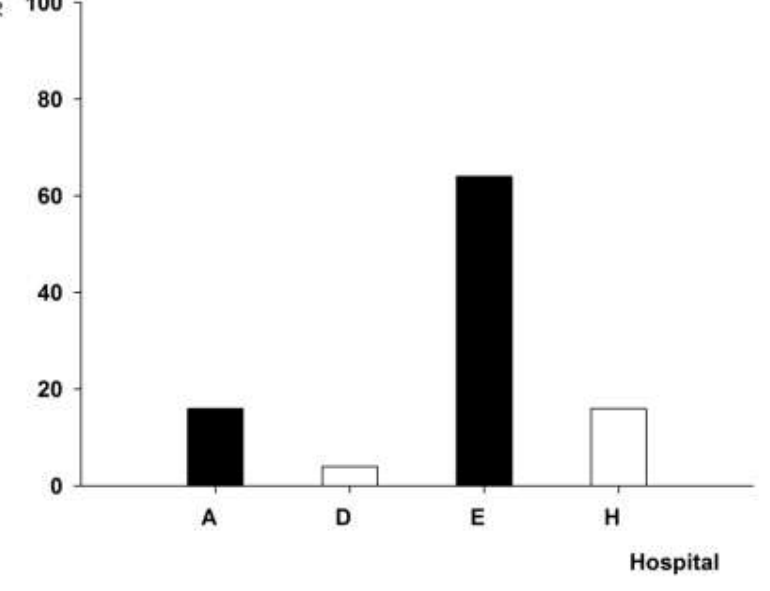
Figure 5. Distribution of A. baumannii isolates with PFGE genotype